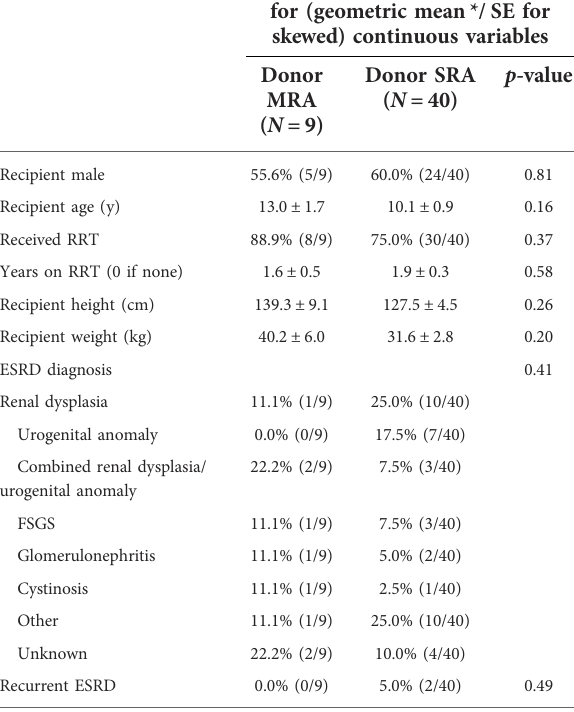
Table 4 . No cases of DGF or graft PNF were encountered. In